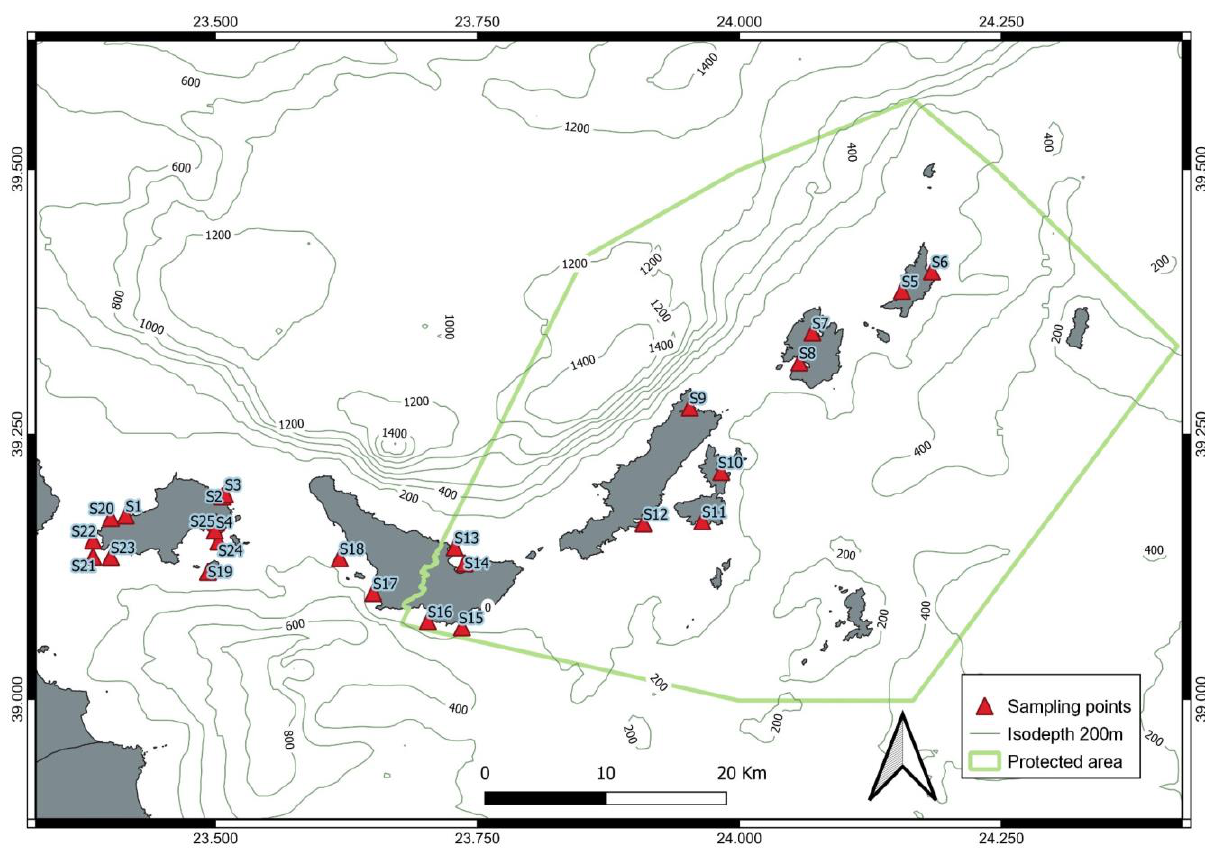
Figure 2. Map showing the limits of the marine park and the sampling stations used to measure the abundance of Holothuria species and physicochemical abundance of Holothuria species and physicochemical parameters.